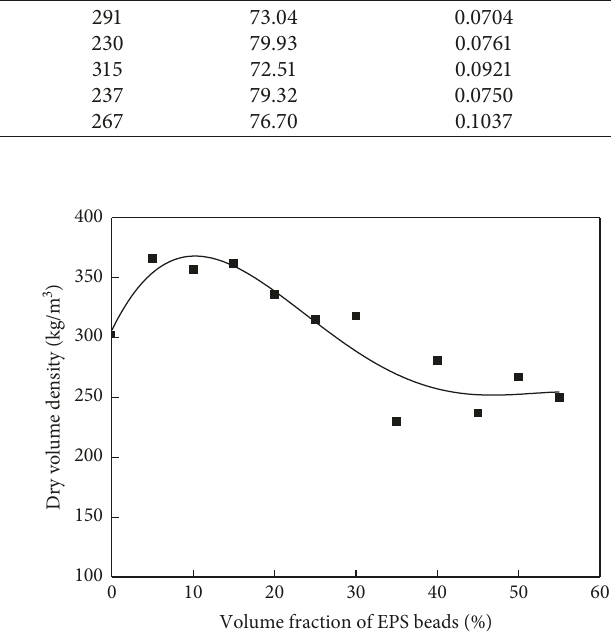
Figure 4: The dry volume densities of FC with various EPS volume